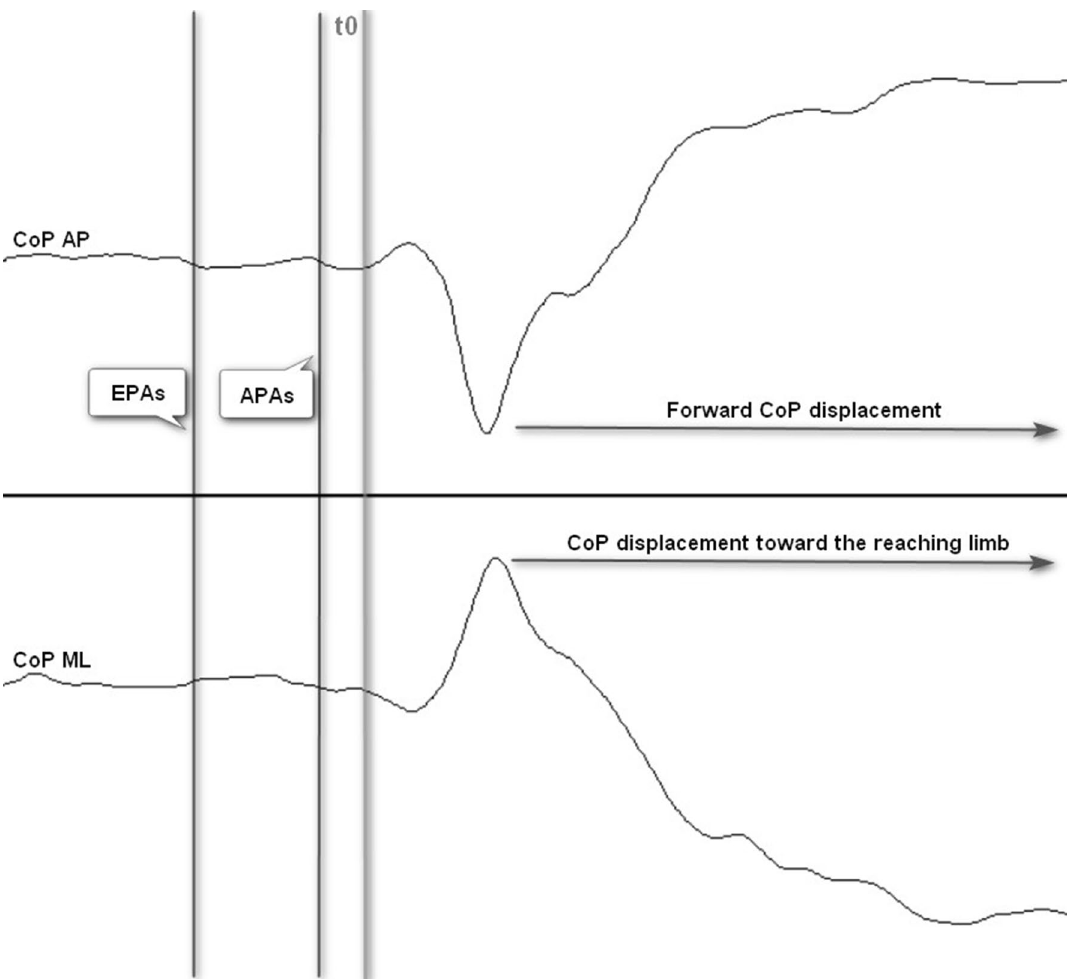
Figure 3. Representation of EPAs and APAs timing and CoP displacement during reaching when the task was assisted by FES-HAND.